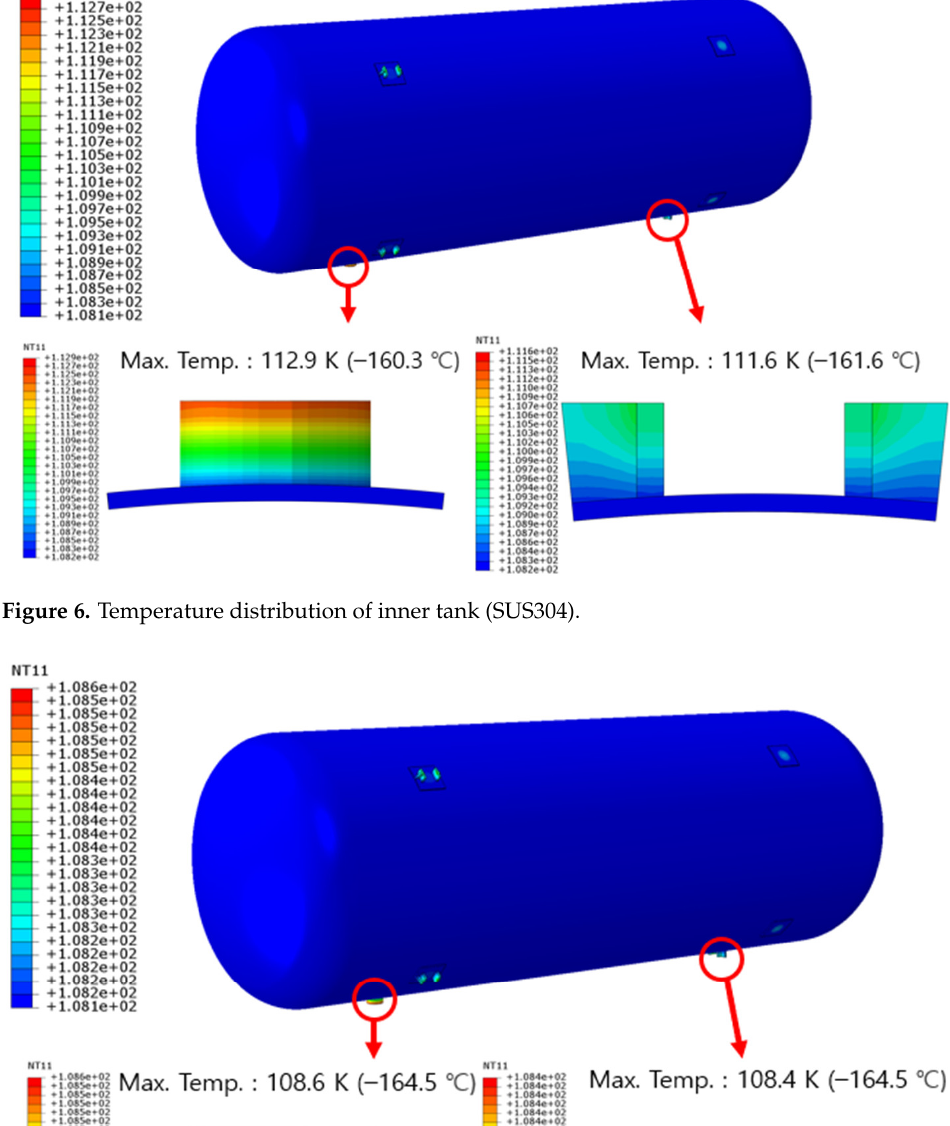
( b ) Figure 8. Temperature distribution of outer tank: ( a ) SUS304; ( b ) AL-5083-O.